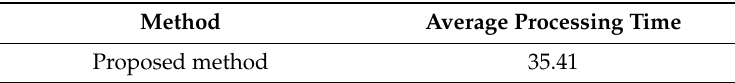
Table 8. Average processing time per image for the classification of open and closed eye images using the proposed method (unit: ms).